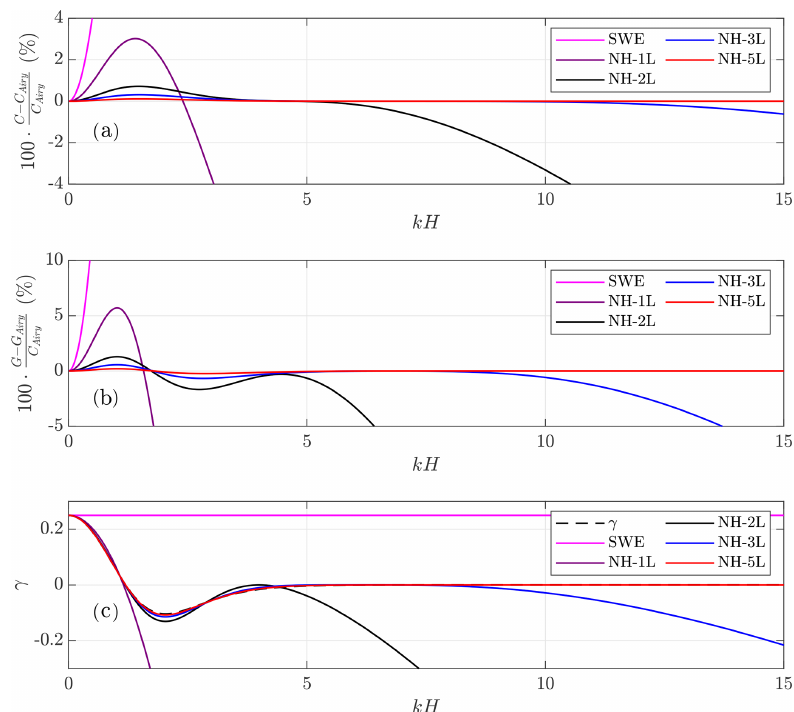
Figure 2. Relative error for the phase velocities (a) , the group velocities (b) , and comparison with the reference shoaling gradient (c) , with respect to the Airy theory for the described multilayer systems (2L, 3L, and 5L), the one-layer non-hydrostatic, and the shallow-water